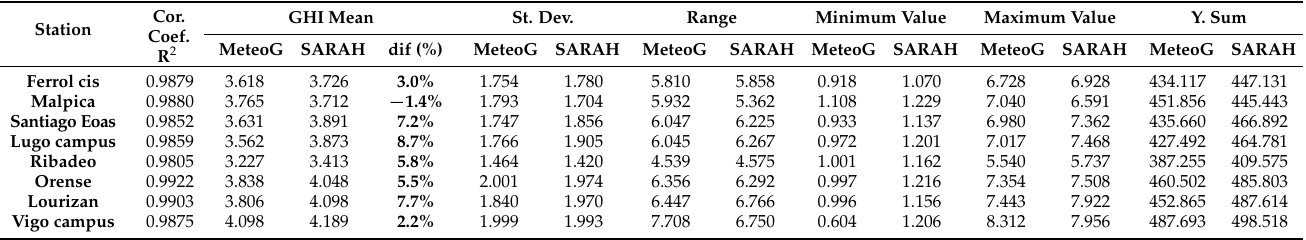
Figure 5. Evolution of the annual mean GHR index: PVGIS vs. MeteoGalicia (Santiago EOAS, 2008–2017). Table 10. Summary comparative study for the 8 stations (period